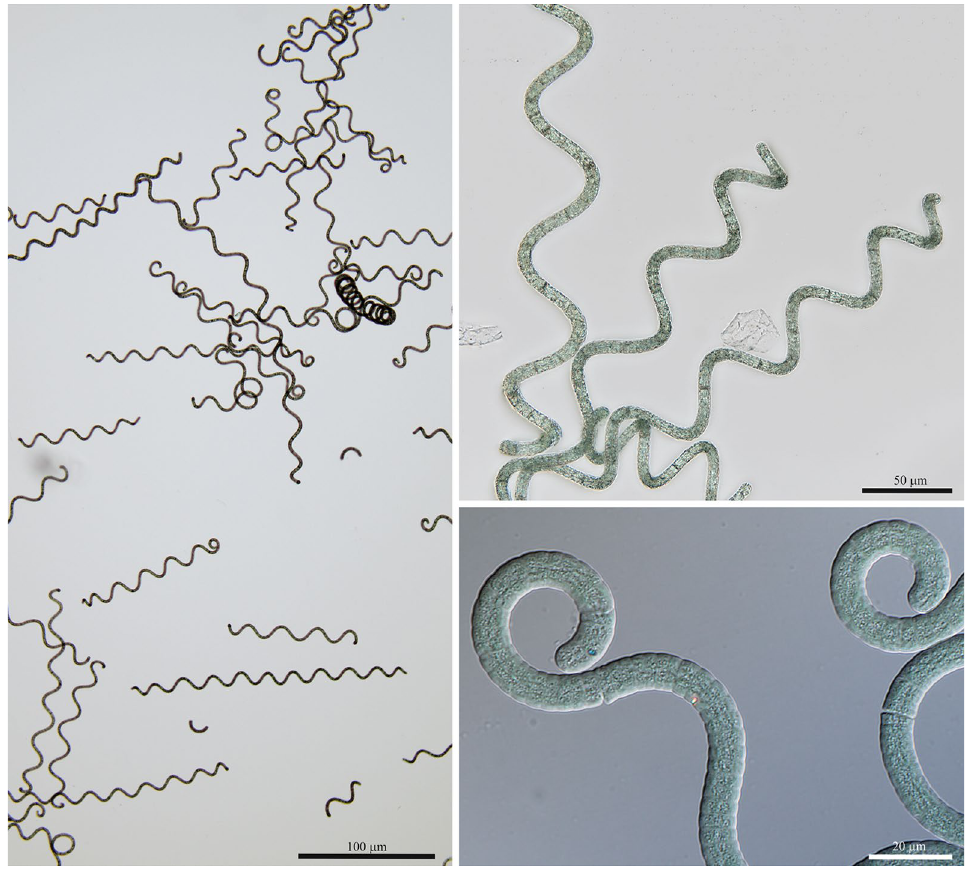
Figure 1. Morphology of material obtained from Dongtai Cibainian Biological Engineering Co. used as reference in this study.